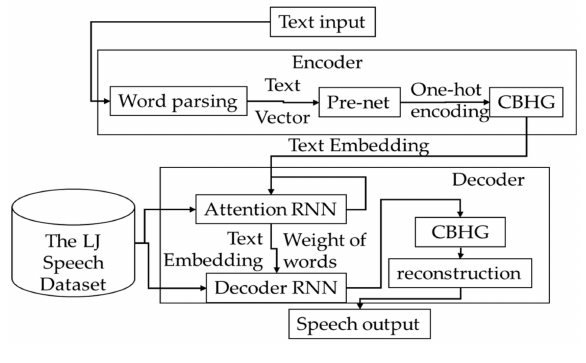
Figure 6. Structure of TWS.